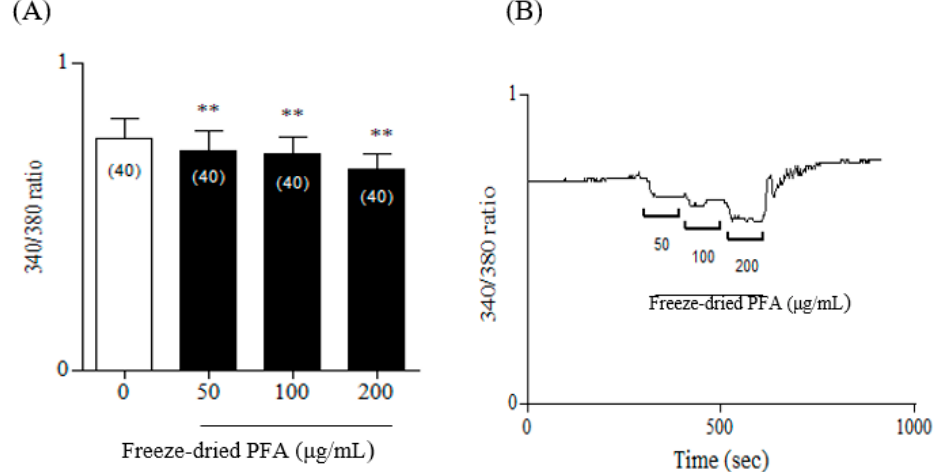
Figure 5. Effect of freeze-dried Perilla frutescens var. acuta (PFA) on basal [Ca 2+ ] i in rat ciliary smooth muscle cells. ( A ) Representative tracing of the [Ca 2+ ] i response evoked by various concentrations of freeze-dried PFA (50 µg/mL, 100 µg/mL, and 200 µg/mL). ( B ) The panel shows the summarized data of freeze-dried PFA-induced changes in [Ca 2+ ] i in rat ciliary smooth muscle cells. The experimental numbers are given in parentheses. The data are represented as mean ± SD. * p < 0.05 and ** p < 0.01.